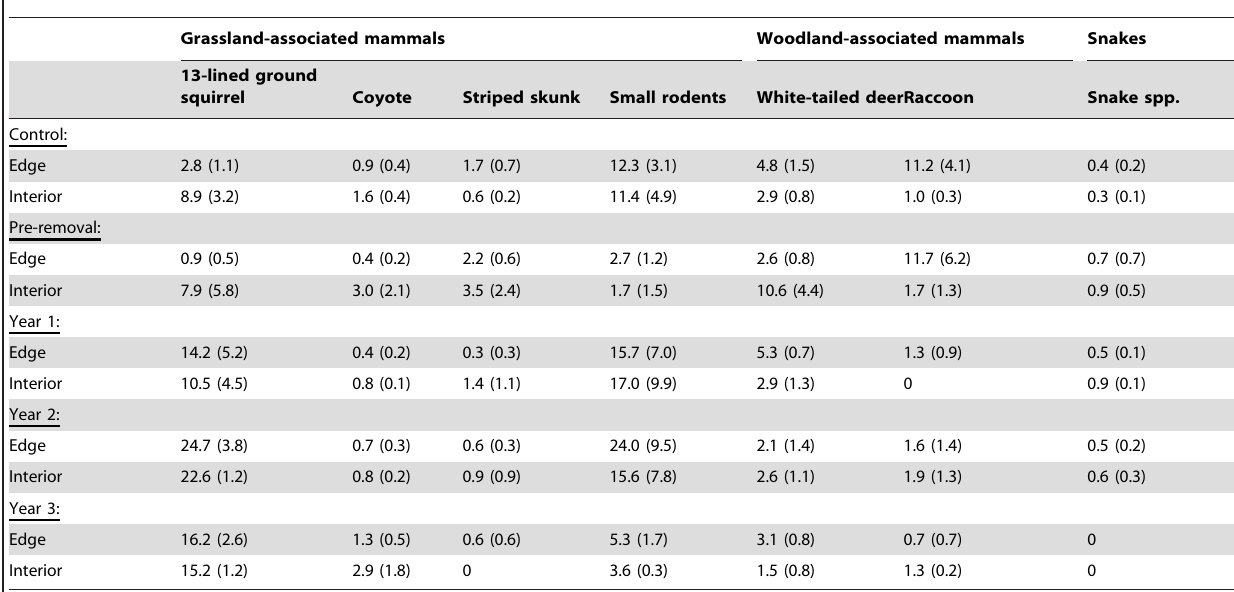
Grassland-associated mammals Woodland-associated mammals Snakes 13-lined ground squirrel Coyote Striped skunk Small rodents White-tailed deerRaccoon Snake